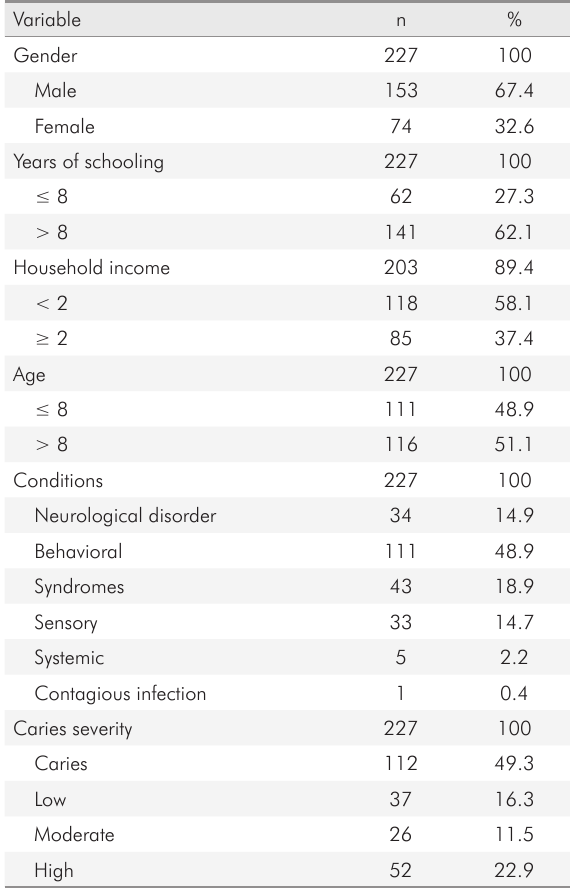
Table 1. Sample characterization and clinical